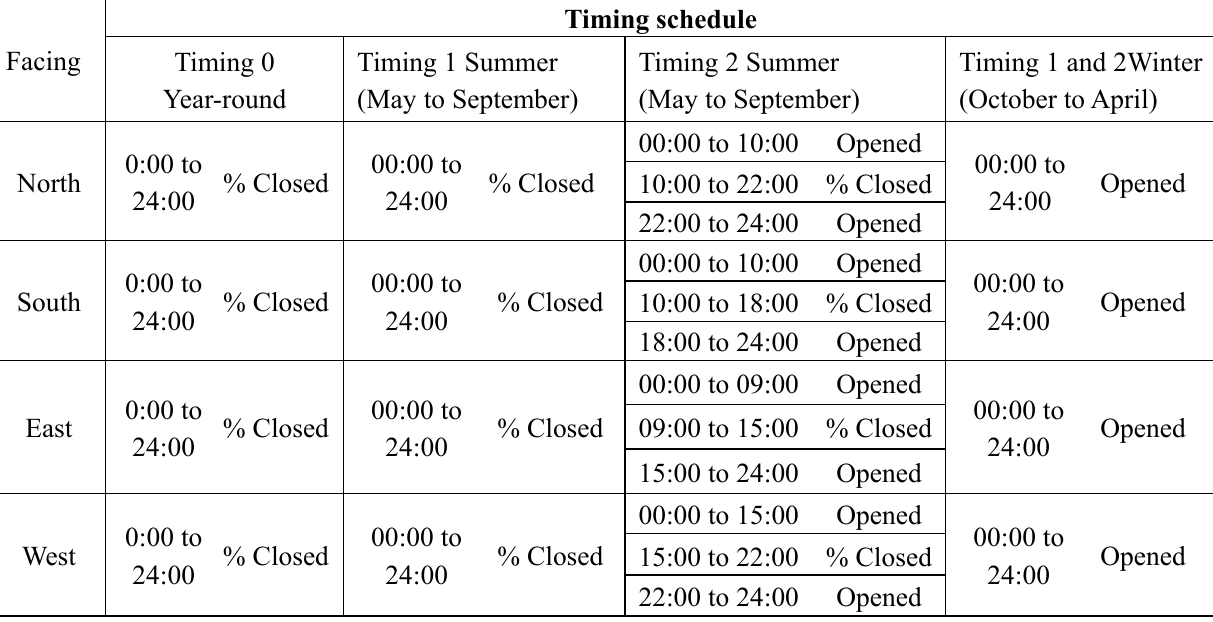
Table 3. Annual timing schedule for louvres and blinds according to